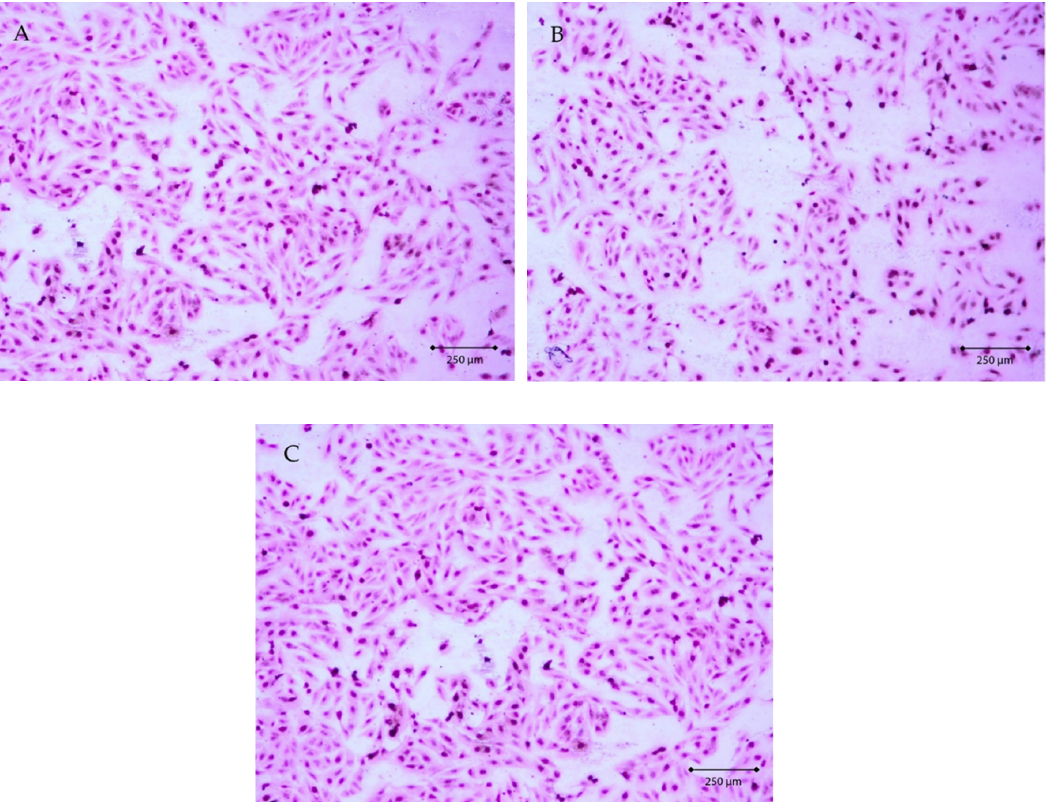
Figure 6. The image of cells of the GM03348 line in hematoxylin-eosin (H-E) stain at 100 × magnification: ( A ) control, ( B ) exposed to silver nanoparticles, particle size 10 nm, concentration 5 µg/mL, ( C ) exposed to AgNPs, particle size 20 nm, concentration 5 µg/mL.